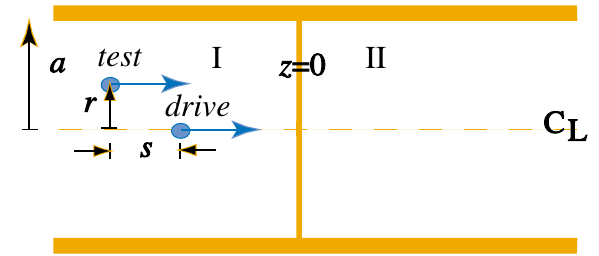
FIG. 2. (Color) A sketch of the geometry of our cylindrically symmetric model showing the two regions, I and II, and the relative positions of the drive and